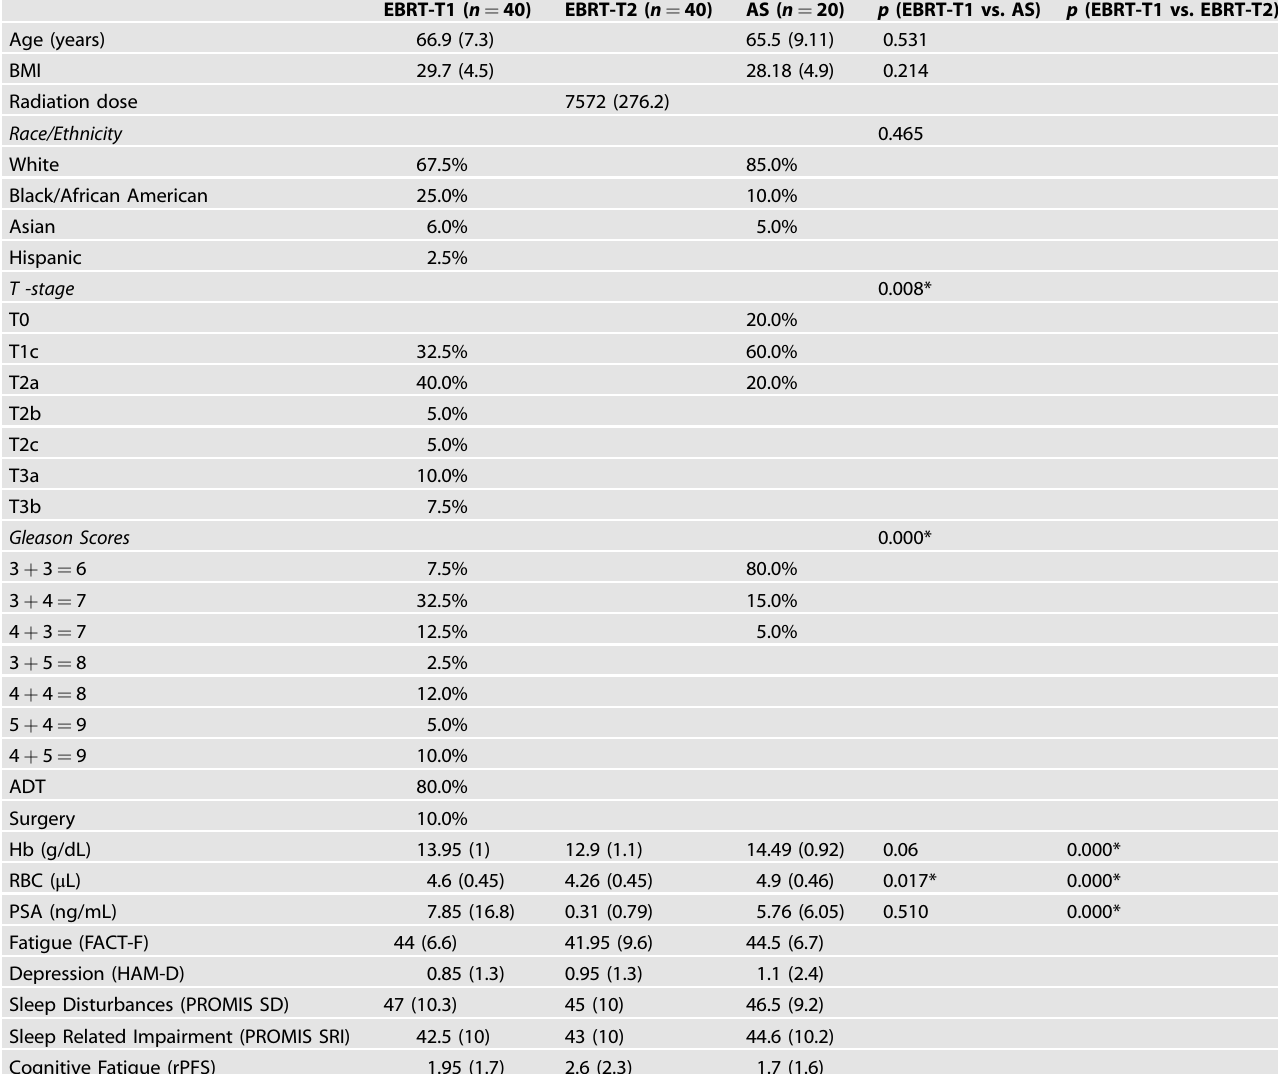
Table 1. Clinical, demographic, and symptoms characteristics of study